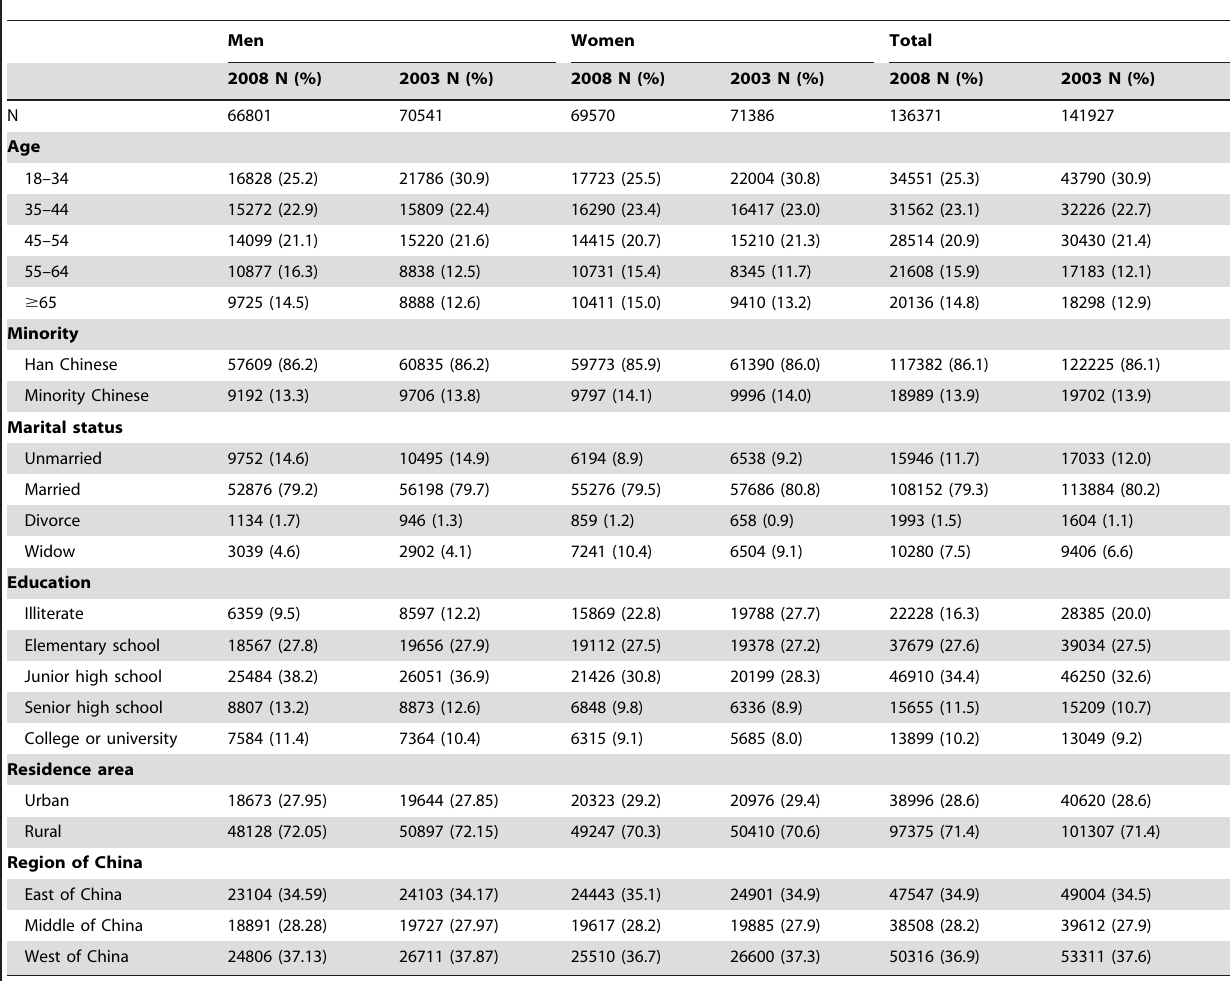
Table 1. Characteristics of survey respondents aged . 18 years in China, 2003 and